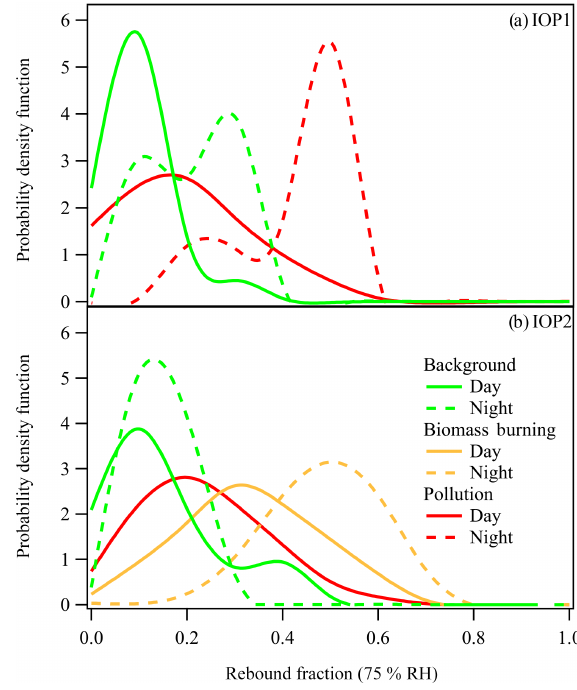
Figure 2. The probability density function of rebound fraction dur- ing (a) IOP1 and (b) IOP2 for categorization by type of air mass and time of day: background conditions (green), Manaus pollution (red), and biomass burning (orange). Solid and dashed lines repre- sent daytime (12:00 to 16:00LT; 16:00 to 20:00UTC) and nighttime measurements (23:00 to 04:00LT; 03:00 to 08:00UTC). Results are shown for an apparatus RH of 75% and for particles having a mobil- ity diameter of 190nm. No data sets fit the classification of Manaus pollution during the nighttime of IOP2 (i.e., absence of a red dashed line in panel b